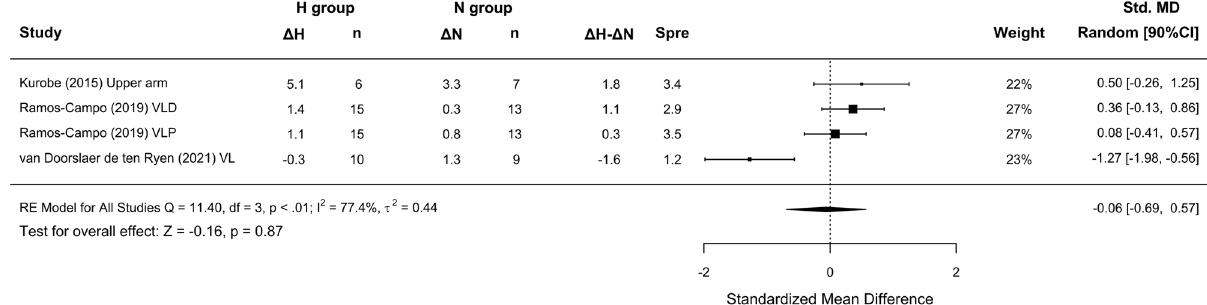
Figure 6. Forest plot of the standardized mean differences of the total effect of the resistance training program between-conditions (hypoxic [H] group vs. normoxic [N] group) on muscle thickness. Δ: mean differences between post–pre in H and N or between H–N; n: sample size; Spre: mean baseline standard deviation; Std. MD: standard mean difference; Random: random effect’s model; CI; confidence interval; Q: test statistic for the test of heterogeneity; df: degrees of freedom; p : p value; I 2 : I 2 test; τ 2 : tau 2 test; Z: z value; VL: vastus lateralis; VLD: vastus lateralis distal; VLP: vastus lateralis proximal.